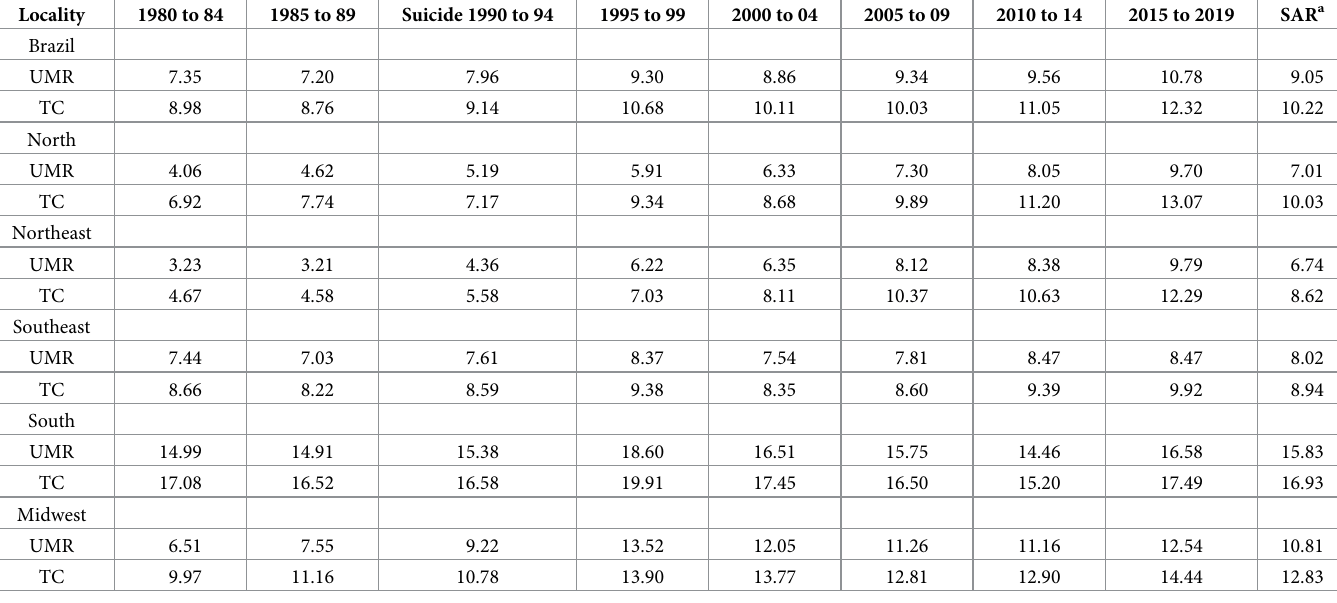
Table 2. Standardized mortality rates per 100,000 men Brazil and its major regions, in five-year periods, in the period 1980–2019.